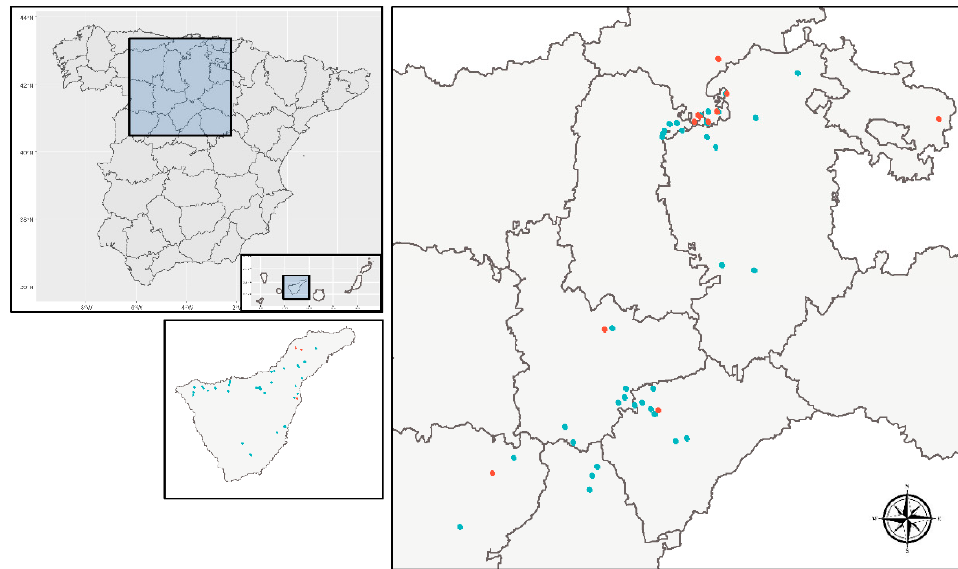
Figure 1. Locations of occasional (blue) and regular surveys (red) in Mainland Spain and the Canary Islands.